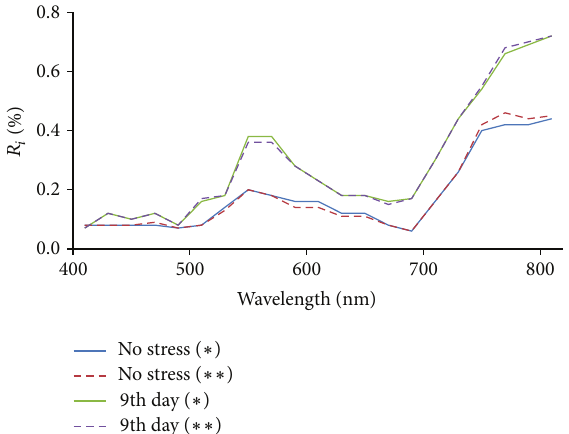
Figure 2: Probability of the light beam passes through 𝑘 chloroplasts for wavelengths 550 nm (a) and 680nm (b).